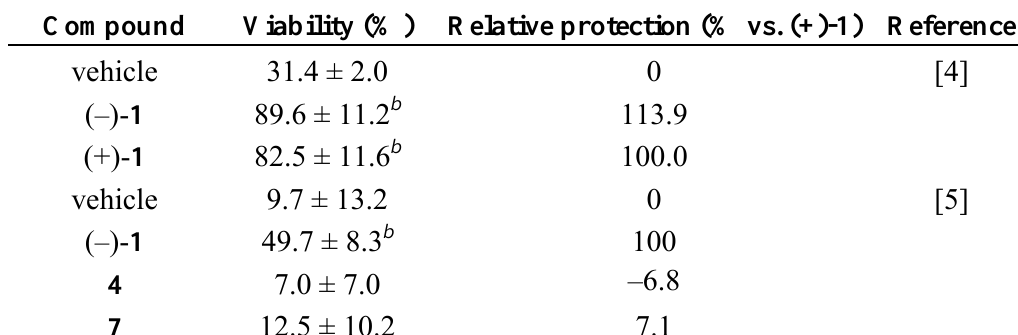
Table 3. Cytoprotective activity of neoechinulin A stereoisomers against SIN-1-induced cell death in NGF-differentiated PC12 cells.